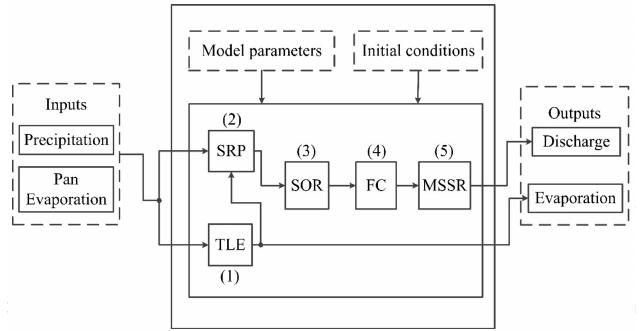
Figure 1. Conceptual structure of the Xinanjiang rainfall-runoff (XAJ) model. TLE is the three-layer evapotranspiration layer; SRP is the saturated runoff production layer; SOR is the runoff separation layer; FC is the flow concentration layer MSSR is short for Muskingum